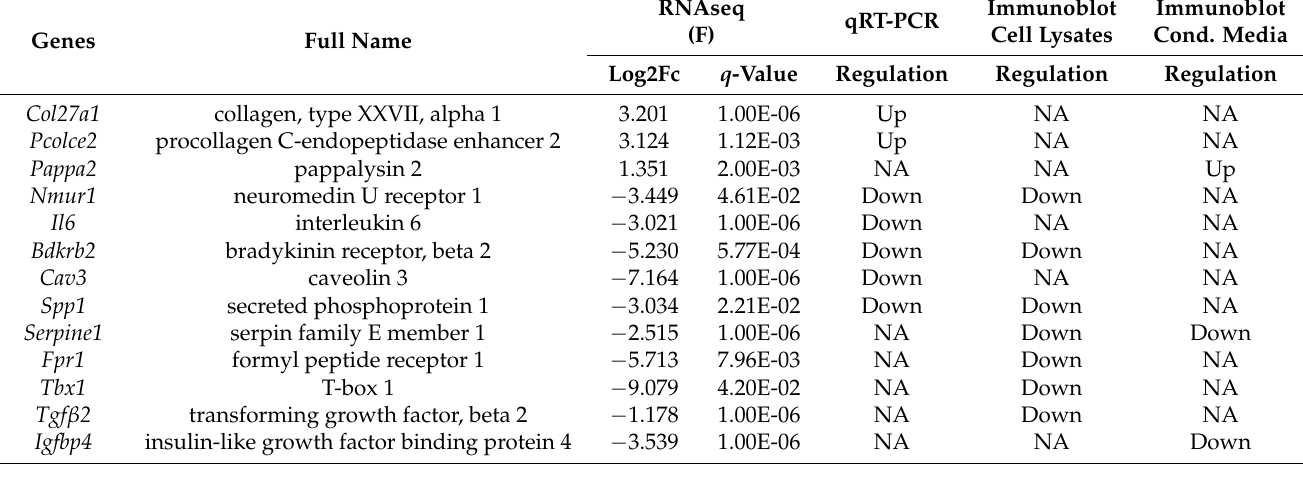
Table 3. Summary of experiments. Selected GOIs that were DEGs in hIGFBP5 pFBs of female HOMO mice were further analyzed by qRT-PCR and immunoblotting (cell lysates and conditioned media abbreviated cond. media). Down (downreg- ulated, blue) and Up (upregulated, red) indicates the direction of regulation in hIGFBP5 pFBs of HOMO female mice as compared to pFBs of WT female mice. NA: not analyzed.